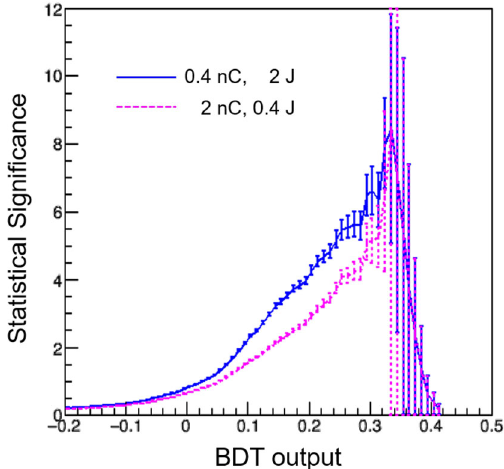
Fig. 9 Expected statistical significance of γγ → γγ signal over the background after one year of operation for (0.4 nC, 2 J) (blue-solid), and (2 nC, 0.4 J) (purple-dashed) Figures 1, 8, 9, should be corrected accordingly, however, the difference from the published paper are virtually unnotice- able except for Fig. 9. We only show updated plot for Fig.